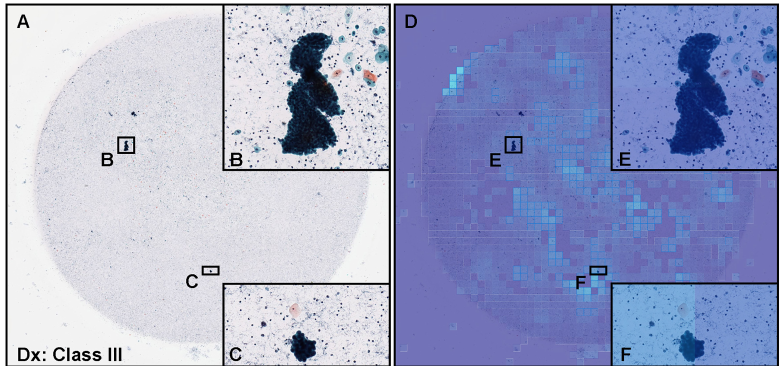
Figure 8. Representative example of false negative prediction. A representative example of neoplastic false negative prediction outputs on urine liquid-based cytology (LBC) whole-slide images (WSIs) from test sets using the ENB1-UC-FS+WS model. According to the cytopathological diagnostic (Dx) report, ( A ) was diagnosed as Class III and included clusters of atypical urothelial epithelial cells ( B , C ). The heatmap images ( D – F ) show false negative predictions ( E , F ) which correspond, respectively, to ( B , C ). The heatmap uses the jet color map where blue indicates low probability and red indicates high